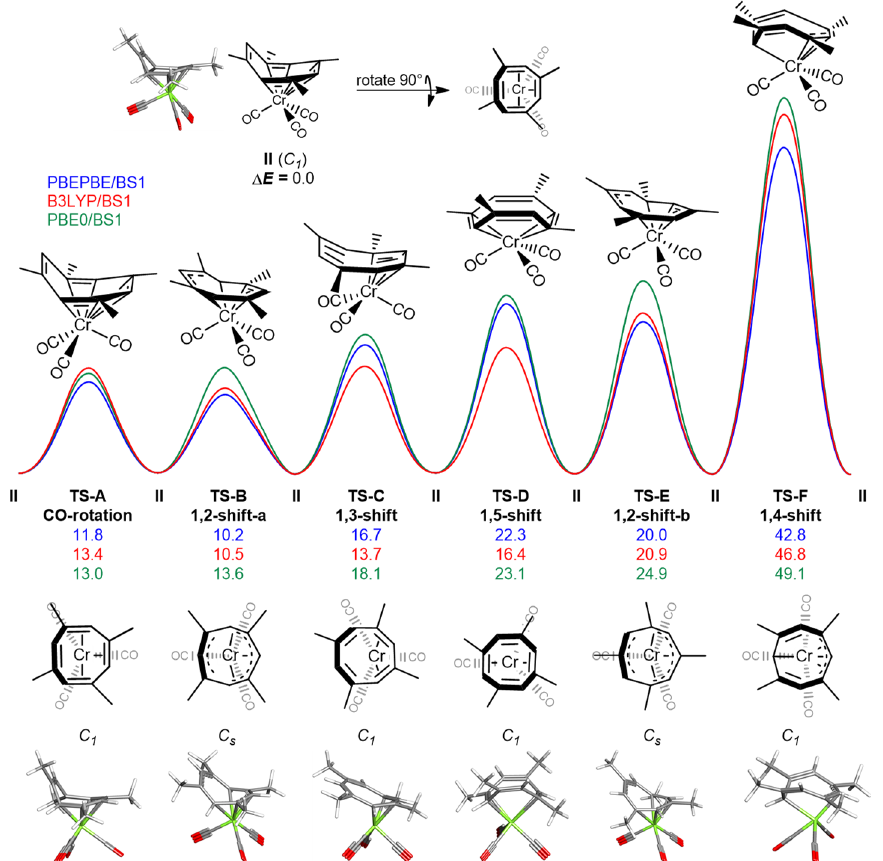
Figure 4. Potential energy surface for various rearrangements in (TMCOT)Cr(CO) 3 . Relative electronic energies are given in kcal mol −1 . Transition states are ordered in reference to Δ E e ‡ values computed using PBE0/BS1.